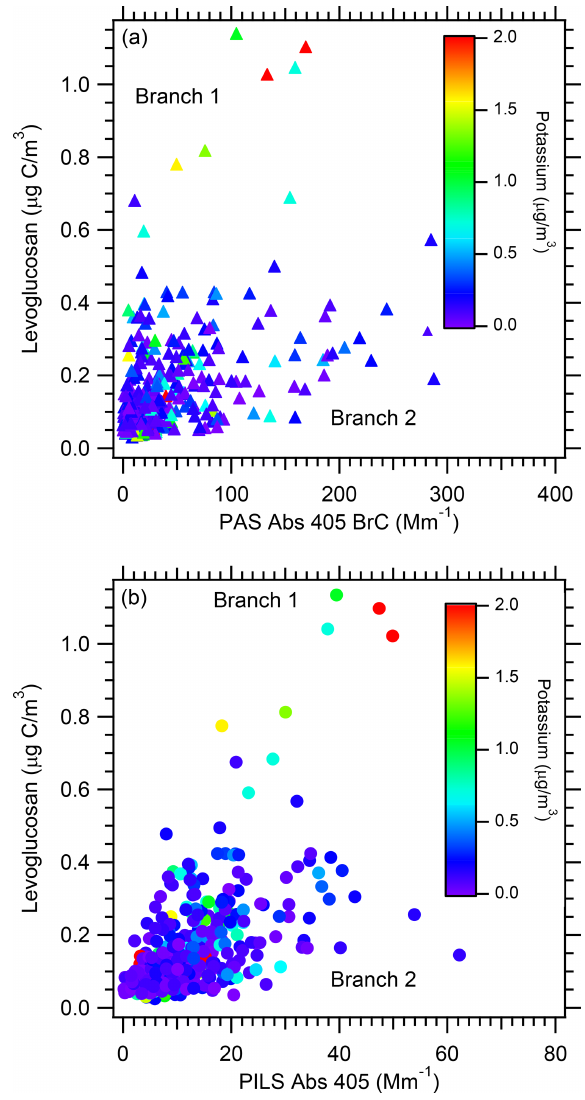
Figure 8. Correlations of levoglucosan on a carbon mass ba- sis vs. (a) PAS total Abs 405 BrC and (b) PILS water-soluble Abs 405 for all WE-CAN flights used in this analysis with the data colored by the PILS water-soluble potassium concentrations. Branch 1 represents data with water-soluble potassium concentra- tions > 0 . 5µgm − 3 and Branch 2 < 0 . 5µgm − 3 . In plot (a) , the equation for the fit and R 2 value for Branch 1 are y = (0 . 006 ± 0 . 001) x + (0 . 027 ± 0 . 049) and R 2 = 0 . 60 and for Branch 2 y = (0 . 001 ± 0 . 001) x + 0 . 118 ± 0 . 006) and R 2 = 0 . 22, respectively. In plot (b) , the equation for the fit and R 2 value for Branch 1 are y = (0 . 024 ± 0 . 002) x − (0 . 081 ± 0 . 038) and R 2 = 0 . 76 and for Branch 2 y = (0 . 006 ± 0 . 001) x + (0 . 073 ± 0 . 007) and R 2 = 0 . 35, respectively. Uncertainties with the least square regressions are 1 standard devi-